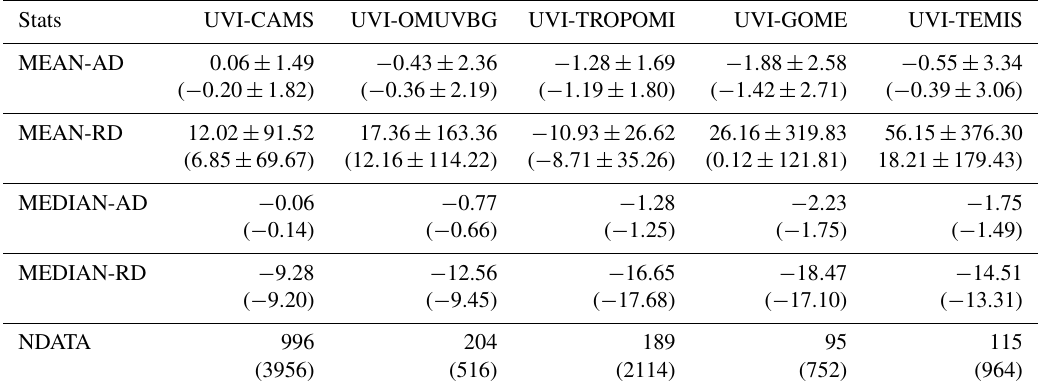
Table A4. Mean and median absolute and relative differences between CS-UVI satellite/model measurements and CS-UVI-RADIO at Anse Quitor. Mean and median absolute and relative differences between ALL-SKY-UVI satellite/model measurements and ALL-SKY-UVI- RADIO at Anse Quitor are in